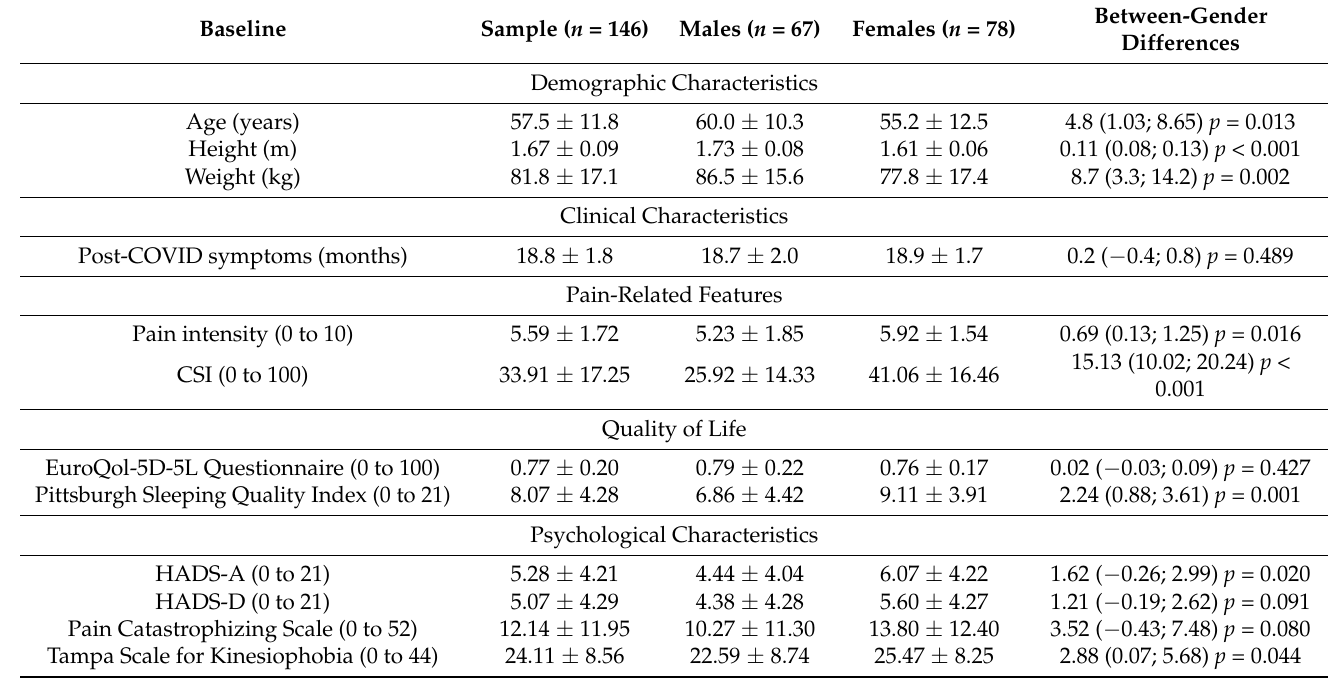
Table 1. Baseline outcomes (mean ± SD) of the